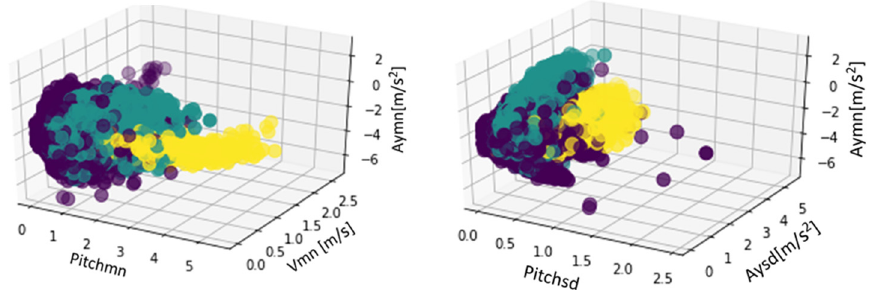
Figure 13. ( A ) Confusion matrices for KNN, SVM:RBF, and RF. ( B ) Class zones examples created by each classifier for two dimensions.